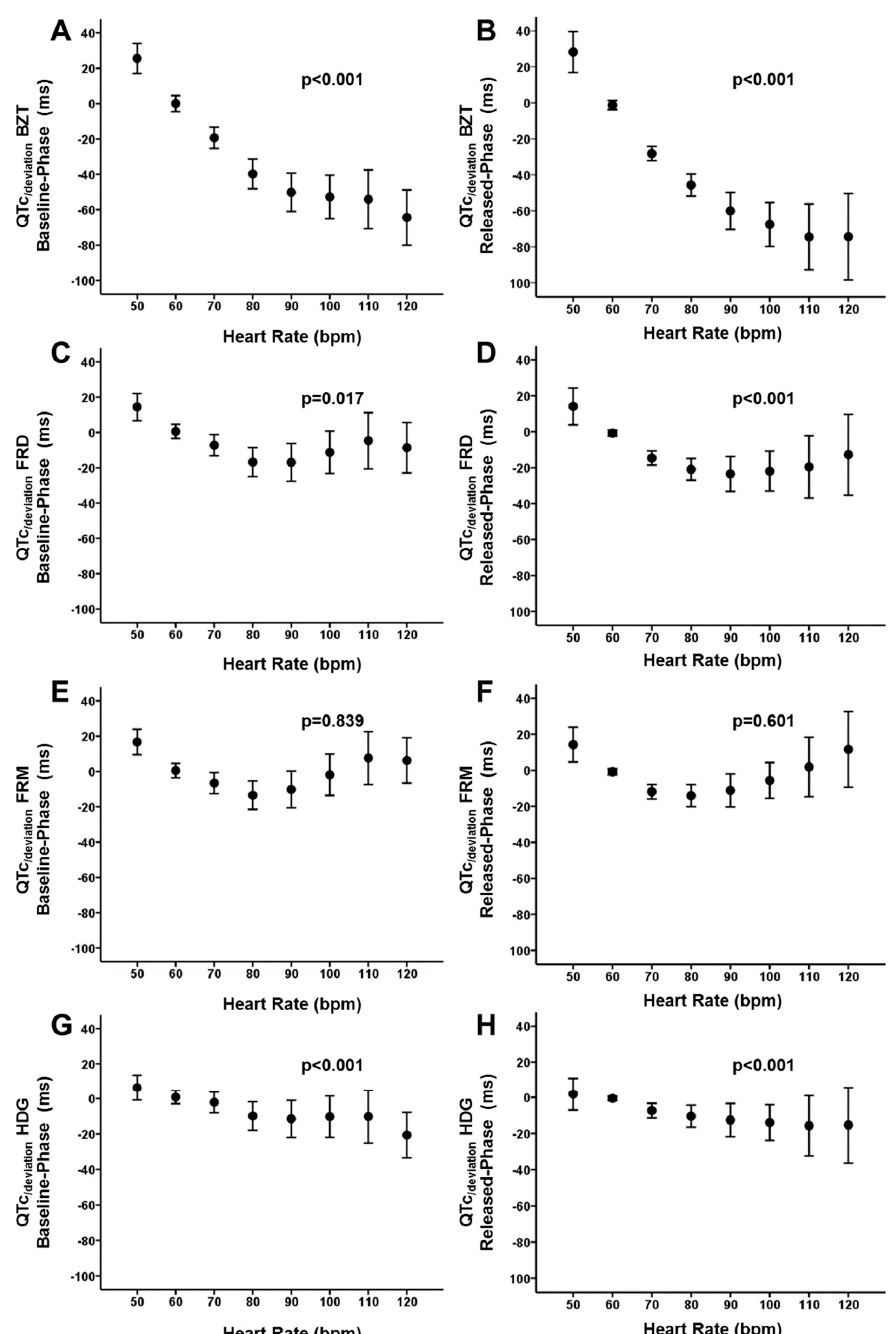
Figure 6. Heart rate dependence of the QTc / deviation . See text for discussion. BZT: Bazett formula. FRD: Fridericia formula. FRM: Framinghan. HDG: Hodges formula.